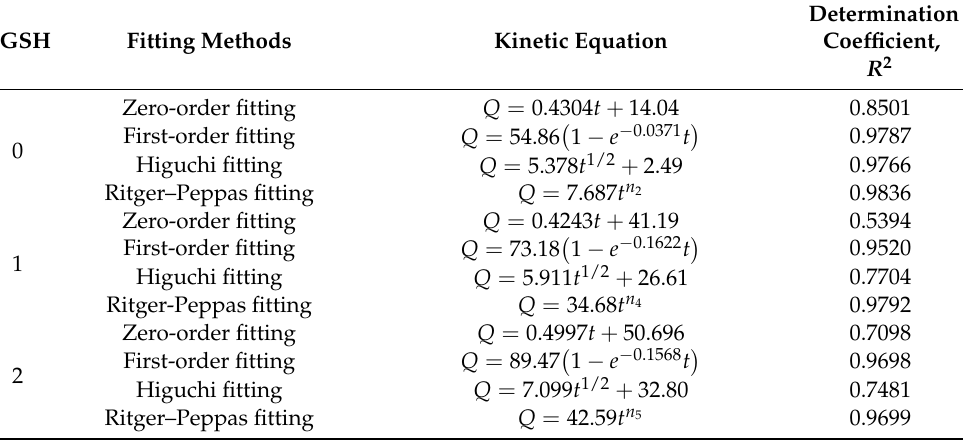
Table A2. Release parameters of Pro@BMMs-SS-Py/ β -CD NPs with different GSH concentrations.